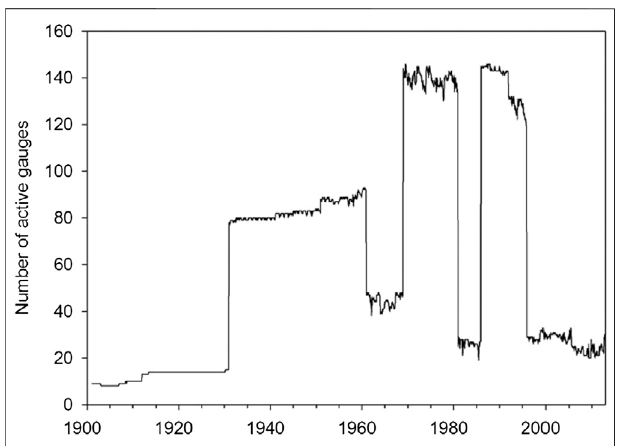
FIGURE 2 | Number of precipitation stations in Chile used by Global Precipitation Climatology Centre dataset (Schamm et al., 2015). Source: Zambrano M. et al.